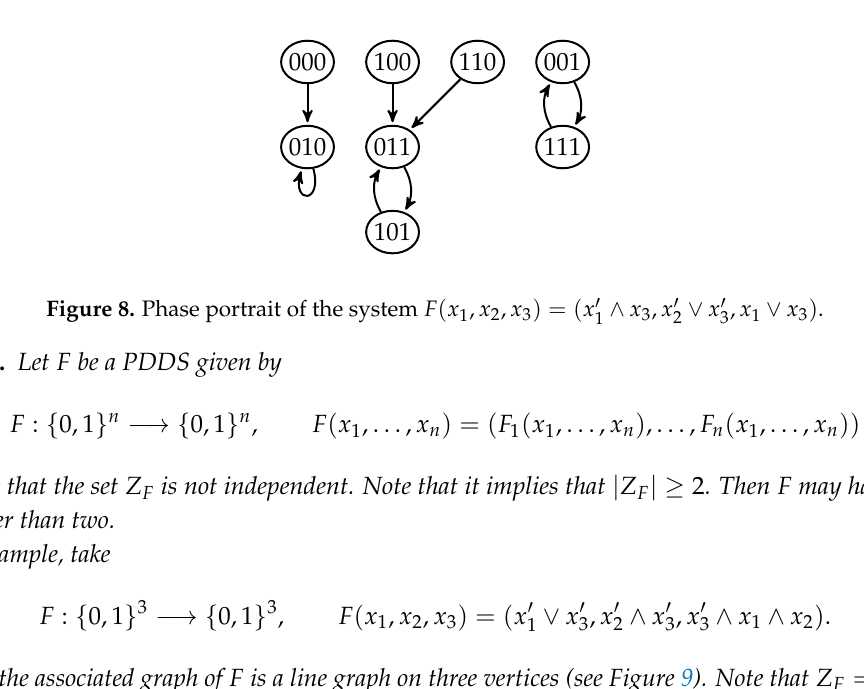
Figure 7. Graph associated with F ( x 1 , x 2 , x 3 ) = ( x (cid:48)